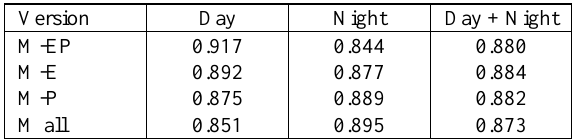
Table 2. Comparison of animal detection by recall among four